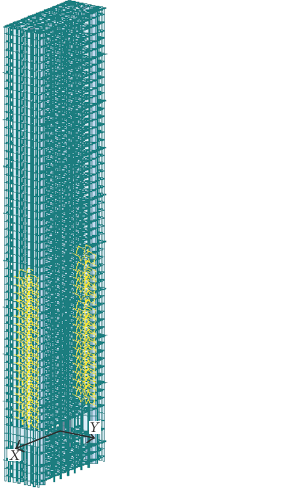
Figure 13: Representation of the orientation